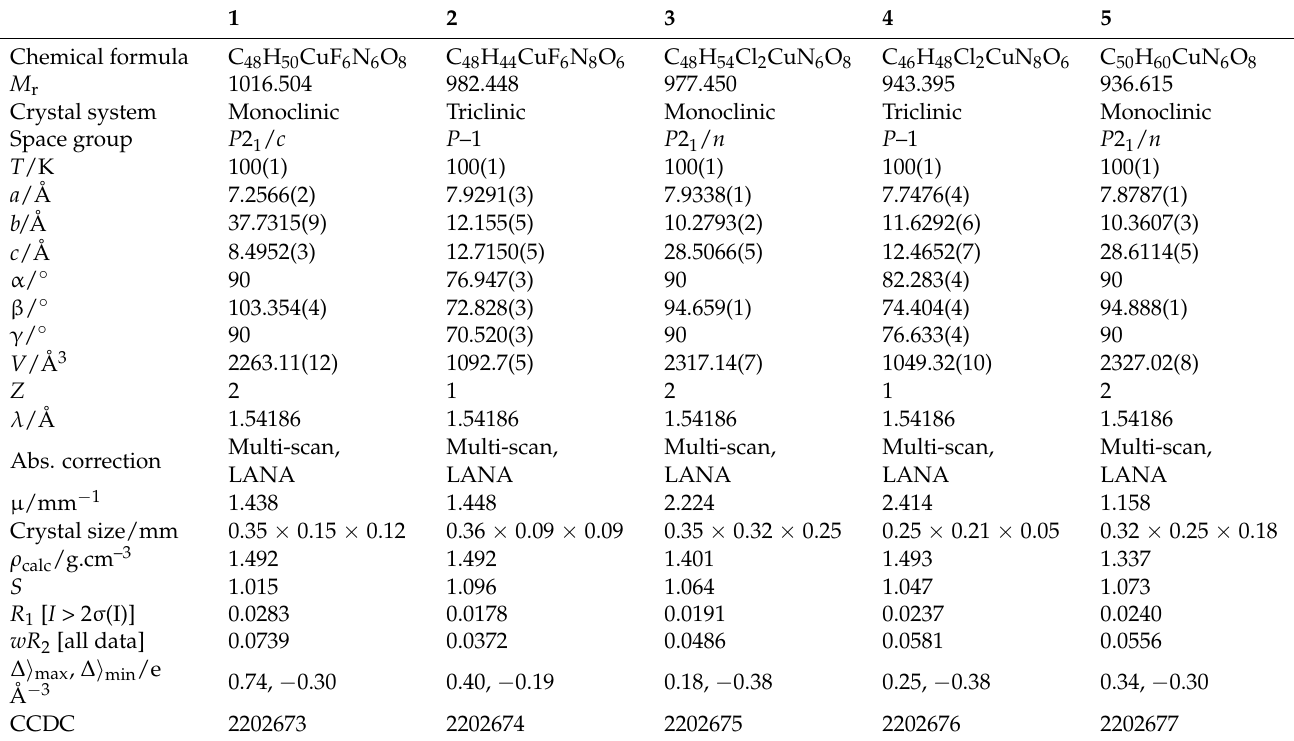
Table 9. Crystallographic data for compounds 1–5